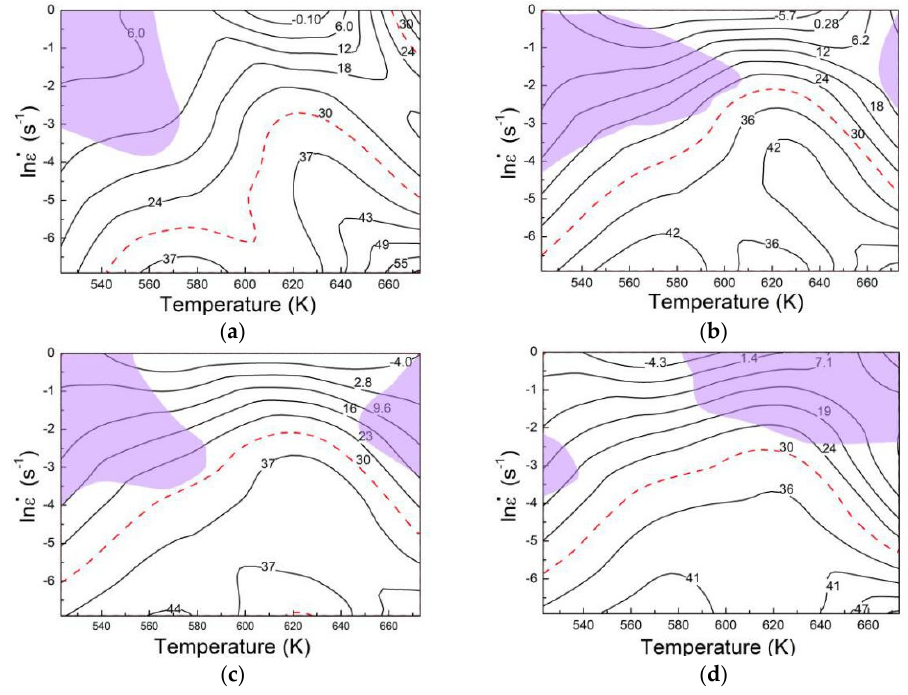
Figure 6. Processing maps of the MZC at the strains of ( a ) 0.1, ( b ) 0.3, ( c ) 0.5 and ( d ) 0.7.